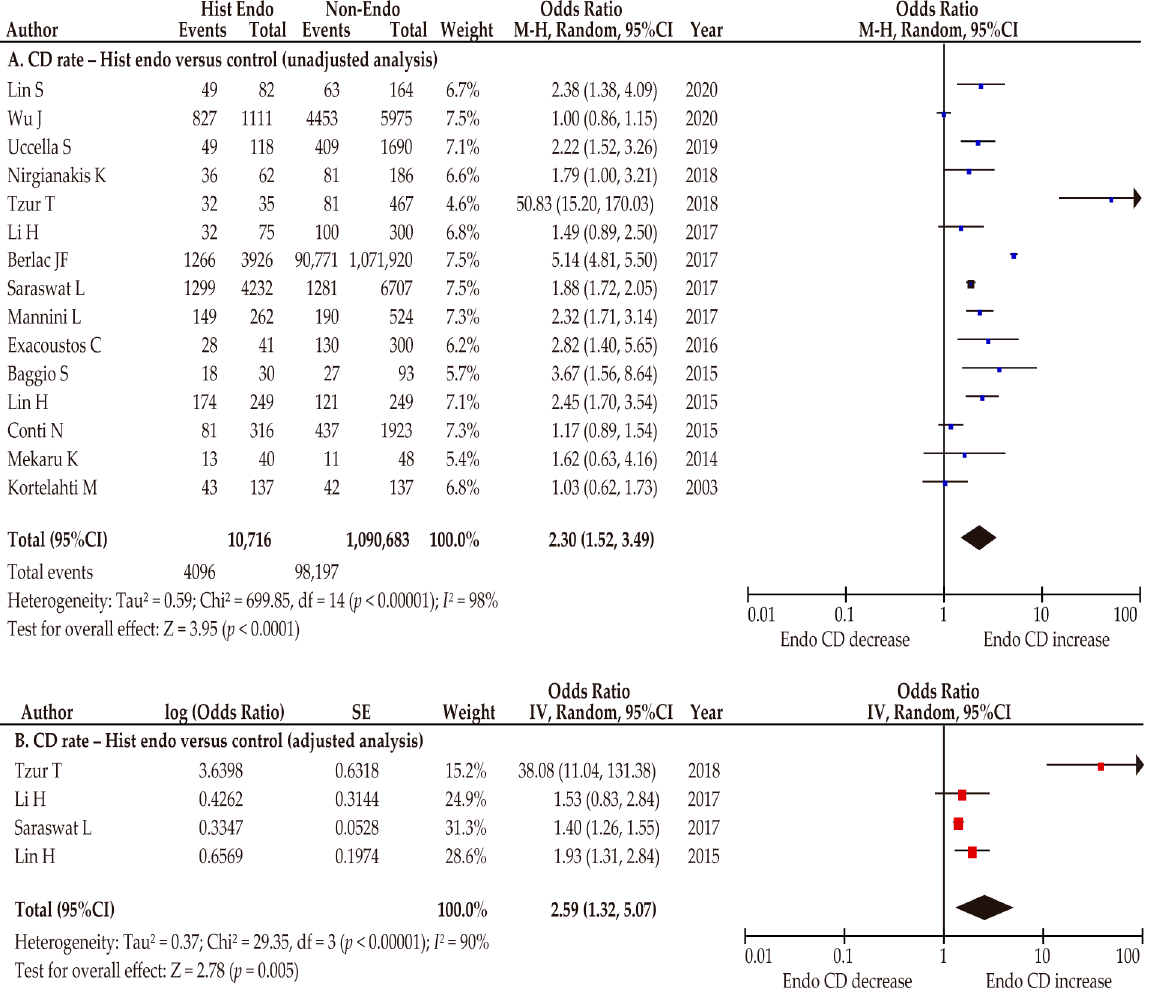
Figure 4. Meta-analysis of the effect of histologically diagnosed endometriosis on the CD rate. The pooled unadjusted ( A ) and adjusted ( B ) odds ratios for CD between women with histologically diagnosed endometriosis and women without endometriosis are shown. The forest plots were modified within the stratum according to year of publication and relative weight (%) of the study. Heterogeneity was considerable in both analyses (( A ), I 2 = 98%; ( B ), I 2 =90%). Some values listed might differ slightly from the original values because the calculation was performed using Revman v5.4.1.